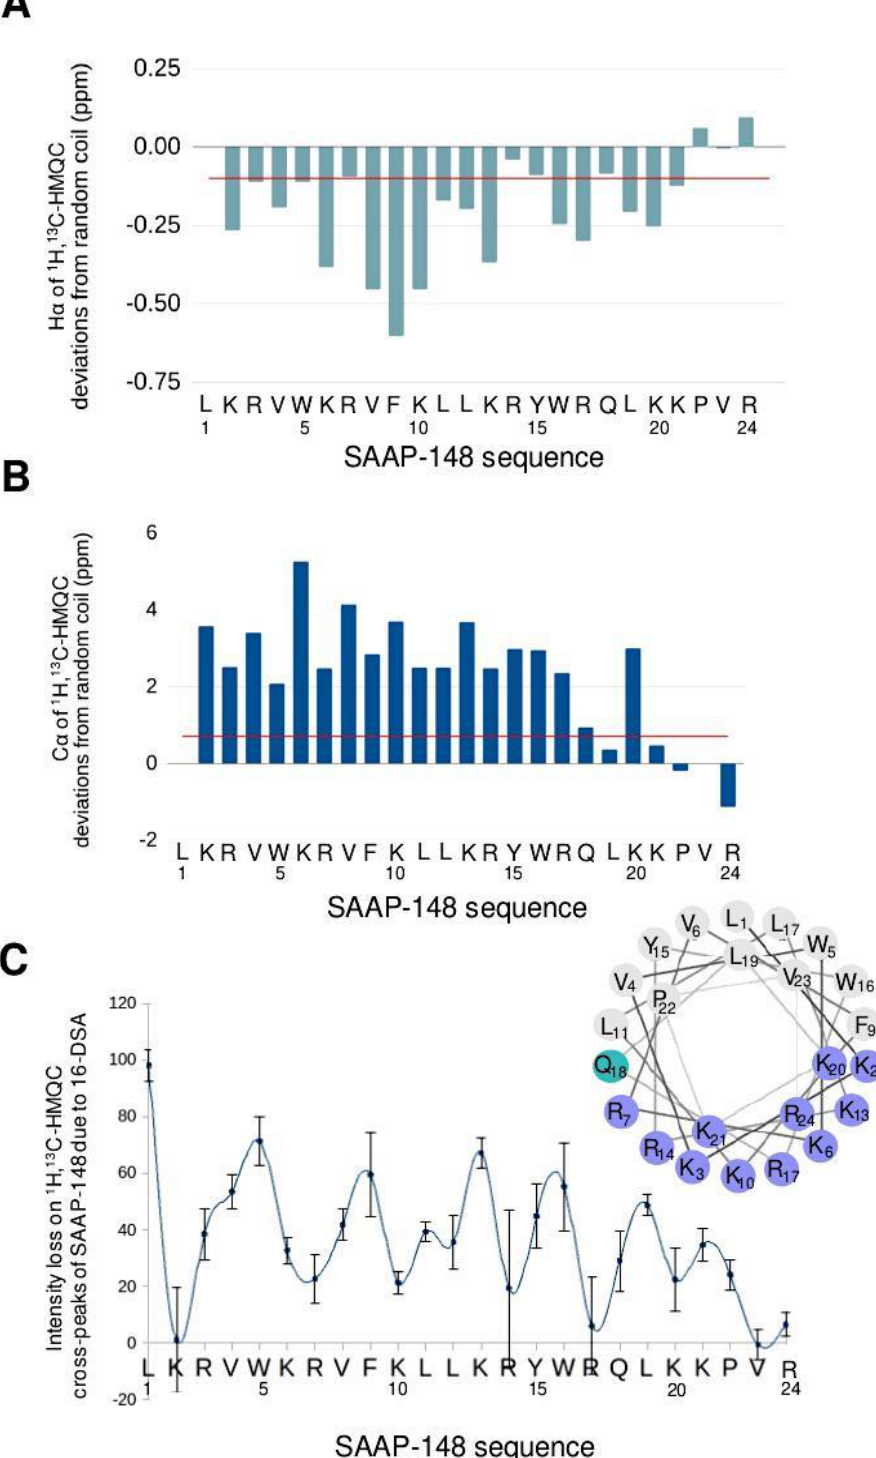
Figure 2. ( A , B ) Hα ( A ) and Cα ( B ) chemical shift deviations from random coil values (see Materials and Methods). ( C ) Percental intensity loss of Hα/Cα 1 H, 13 C-HMQC peaks in the presence of paramagnetic 16-DSA. Insert shows a helical wheel for SAAP-148 peptide (created using Netwheels web server [88]).